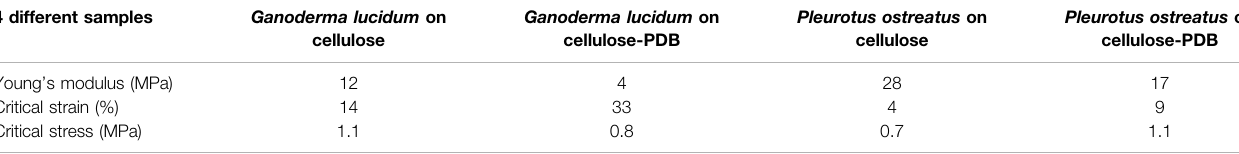
TABLE 3 | Summary of main properties of mycelium fi bers (Haneef et al., 2017). 4 different